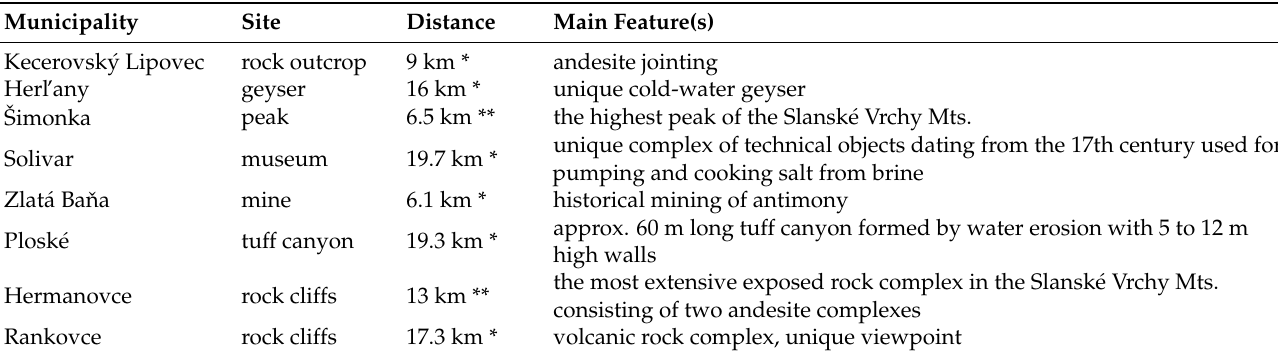
Table 4. Geosites near the Dubnik Opal